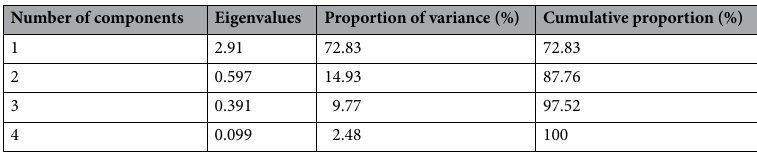
Table 7. Granger causality testing 14-day CI predictive of mobility variables for different lag orders.